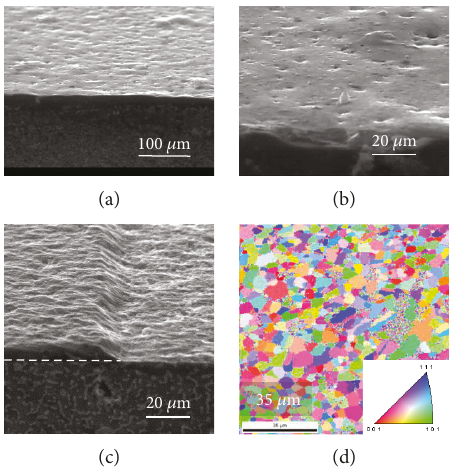
Figure 3: (a) SEM image (sample is 70 ° tilted) of the laser- crystallized thin e-beam-deposited Si layer at the cross section; (b) the corresponding higher magni fi cation SEM image; (c) the boundary at the region deposited with 10 μ m a-Si (left side) and that without a-Si (right side) after laser crystallization, the dashed line indicated the boundary between the additional layer and the pc-wafer; (d) EBSD image of the laser-crystallized thin e-beam-deposited Si layer on top of the pc-Si